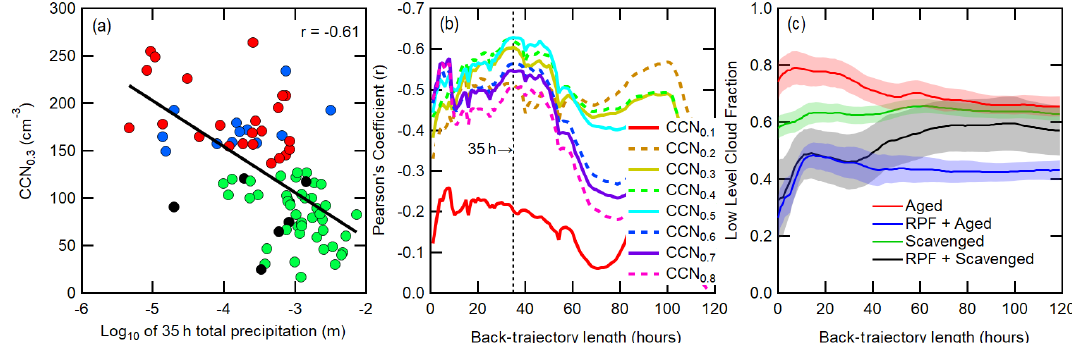
Figure 5. (a) Correlation of MBL CCN 0 . 3 and total precipitation that occurred along a 35h HYSPLIT back trajectory. Colors correspond to the legend in (c) . (b) CCN and back-trajectory total precipitation correlation coefficient as a function of back-trajectory length. The vertical dashed line indicates a peak in correlation with CCN 0 . 3 at 35h. (c) Particle regime averaged ERA5 low-level cloud fraction over the 5d back trajectory. Shaded areas represent the standard